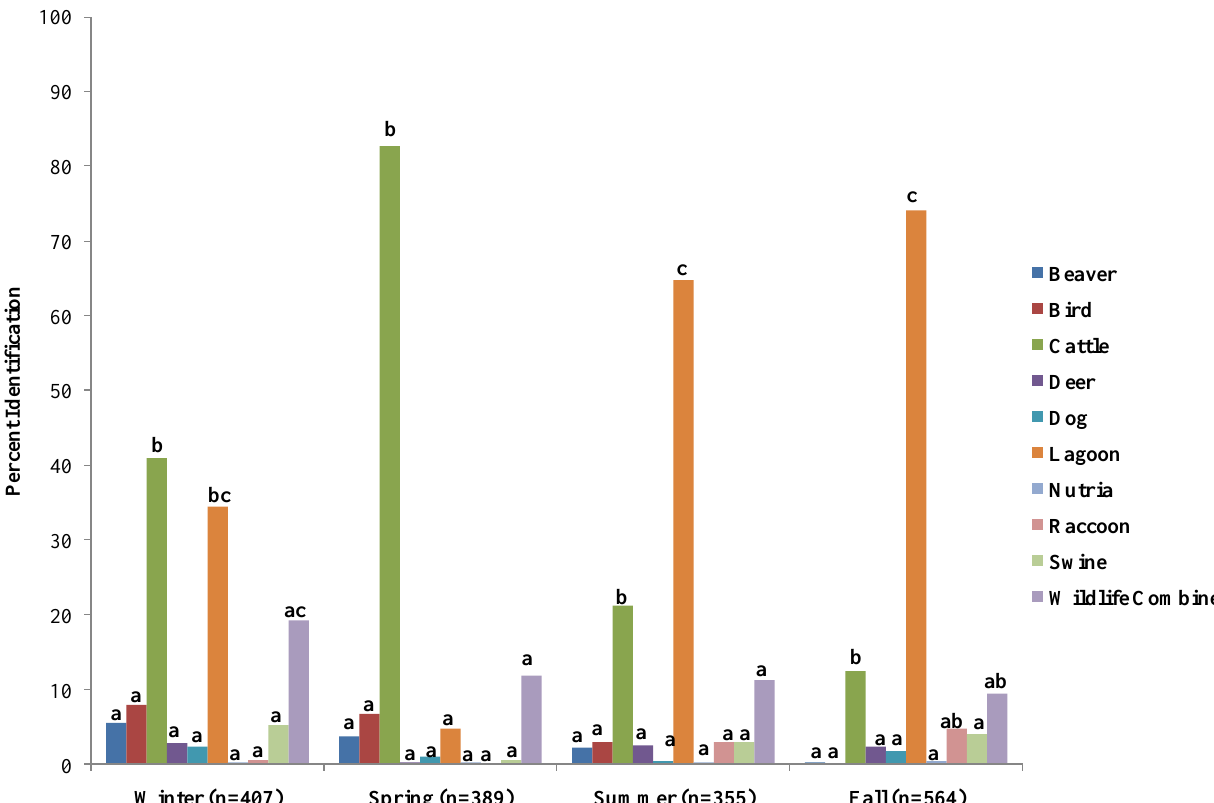
Figure 6. Seasonal host source identification of E. coli isolates from three Six Runs Creek sampling sites adjacent to waste application field two (WAF2).